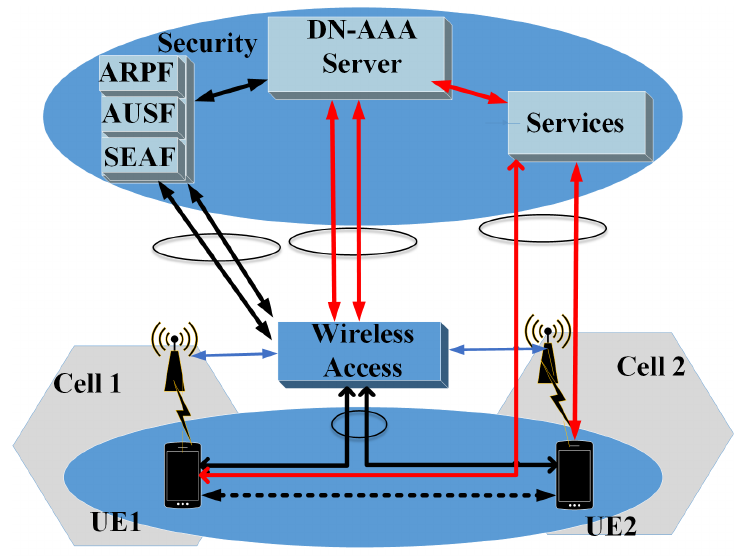
Figure 2. Unified modular